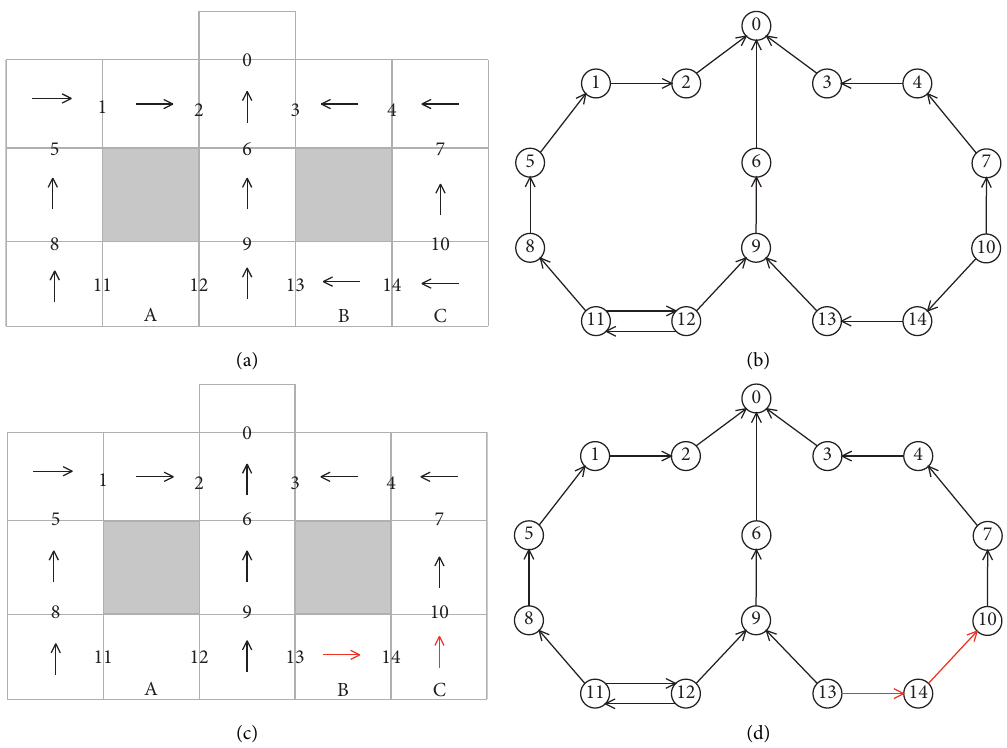
Figure 2: The discretization of space with sign direction and its corresponding directed network. Figure (a) and (c) are the same discrete space with different sign directions, and Figure (b) and (d) are directed networks corresponding to Figure (a) and (c), respectively. In Figure (c), the sign direction in grid B and grid C points in the opposite direction compared with Figure (a). Accordingly, the corresponding directed network is reformed from Figure (b) to Figure (d) by changing the arc direction between node 13, node 14, and node